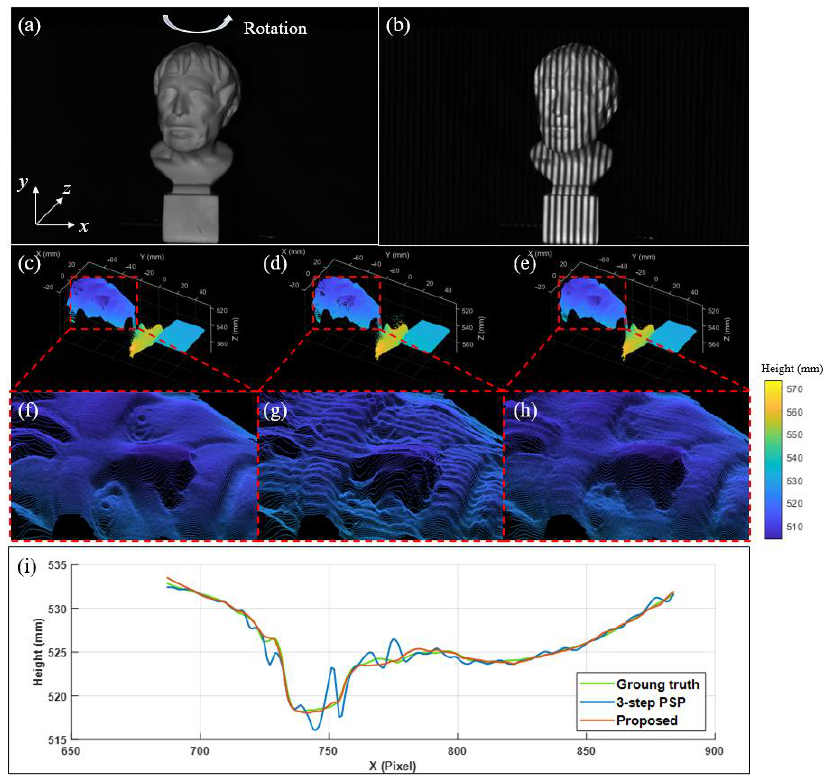
Figure 8. Measurement results of a rotating scene in an actual FPP system. ( a ) Rotating sculpture. ( b ) One of the deformed fringe patterns. ( c – e ) Reconstructed results of 12-step PSP, 3-step PSP, and proposed method, respectively. ( f – h ) Local enlarged results corresponding to ( c – e ). ( i ) Section line in 400th row of the height (Z) distributions of three methods.